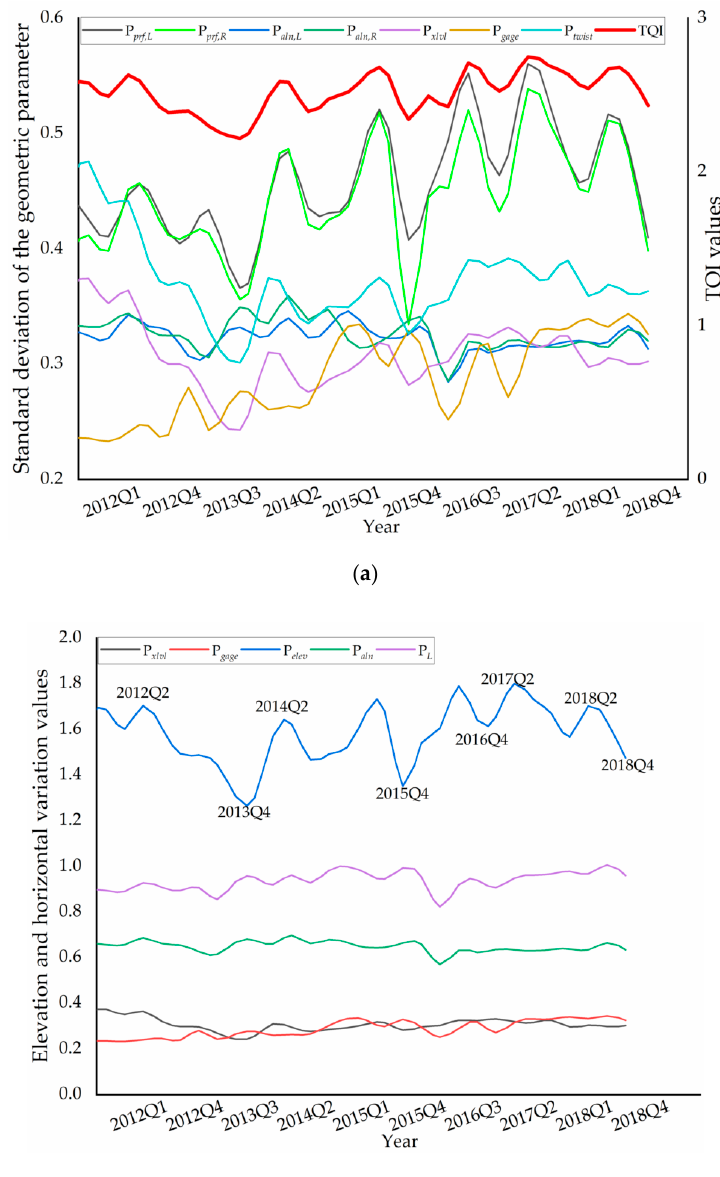
Figure 1. ( a ) Track quality index (TQI) and track geometric parameters and ( b ) elevation and horizontal variation. P prf , L , P prf , R , P aln , L , and P aln , R are the left surface irregularity, right surface irregularity, left track alignment irregularity, and right track alignment irregularity, respectively; P elev is the sum of P prf , L , P prf , R , P xlvl , and P twist ; P aln is the sum of P aln , L , and P aln , R ; and P L is the sum of P aln , L , P aln , R and P gage . Table 1. Management standards for TQI and single parameter’s standard deviation for 200-m track segment for di ff erent speed classes (unit: mm). Speed P aln , L P aln , R P prf ,